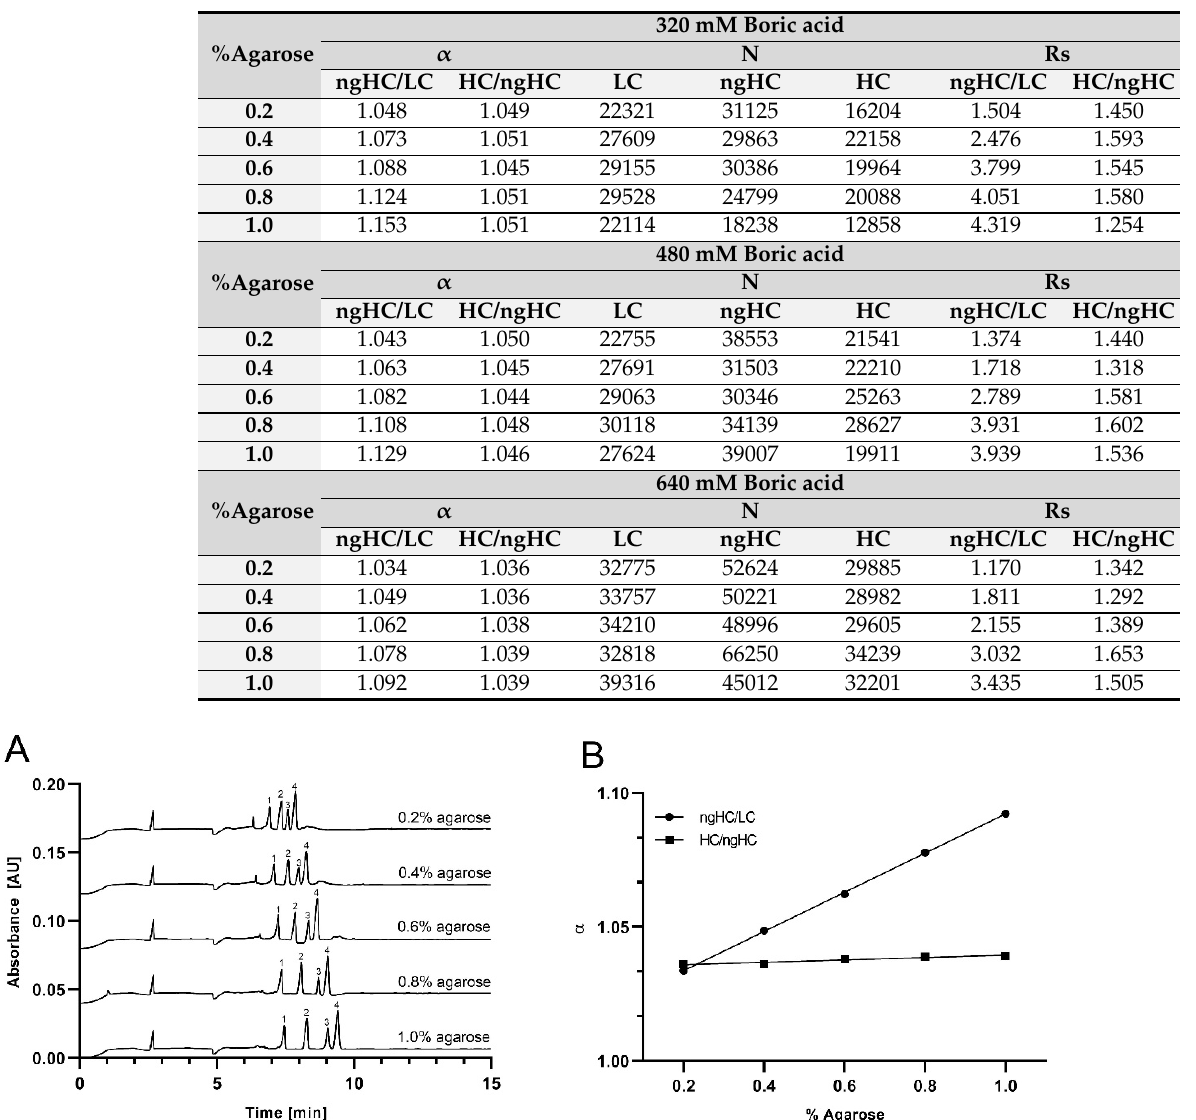
Table 2. Separation selectivity ( α ), efficiency (N) and resolution (Rs) values with the agarose-TBE gel-buffers evaluated in this study.